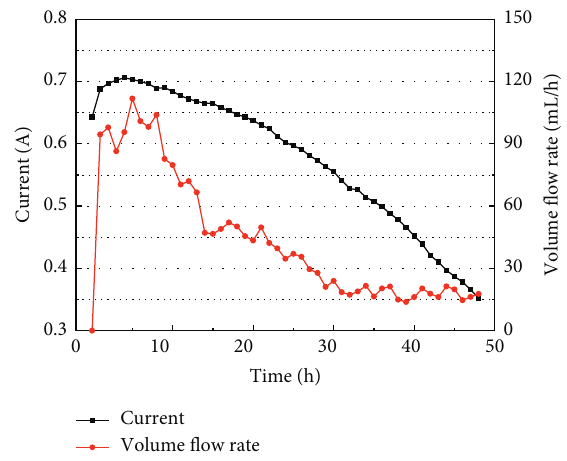
Figure 4: Total drainage water vs. current in the soils.